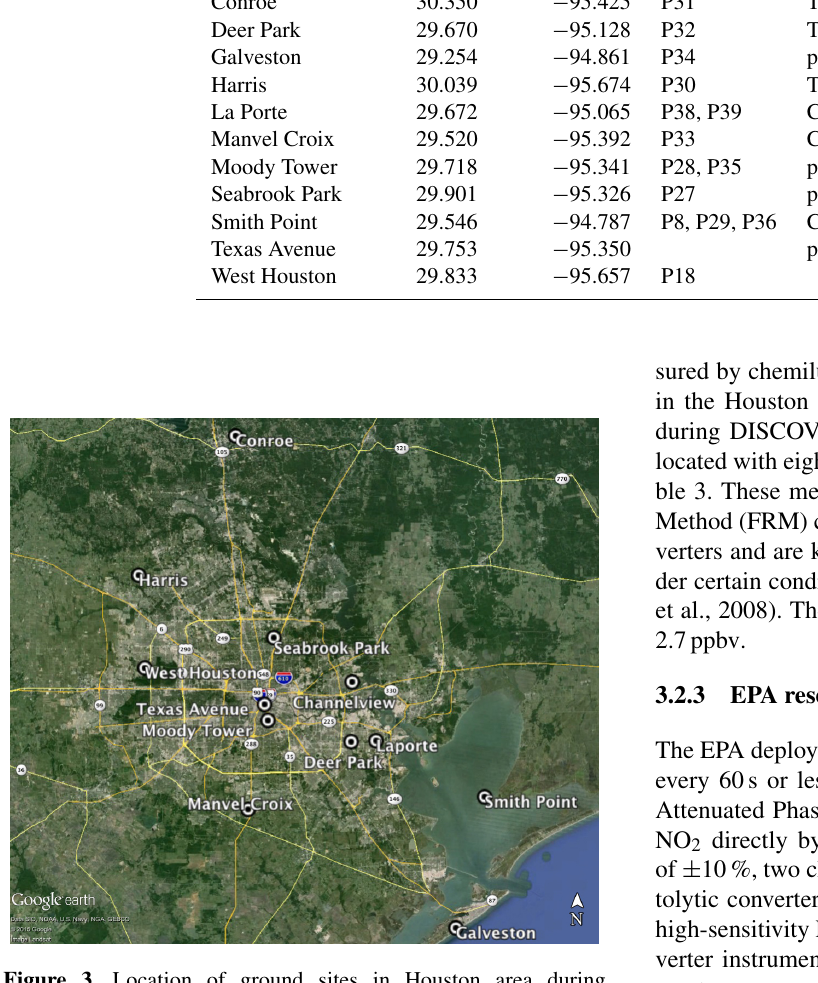
Figure 3. Location of ground sites in Houston area during DISCOVER-AQ 2013. Major roads are shown in